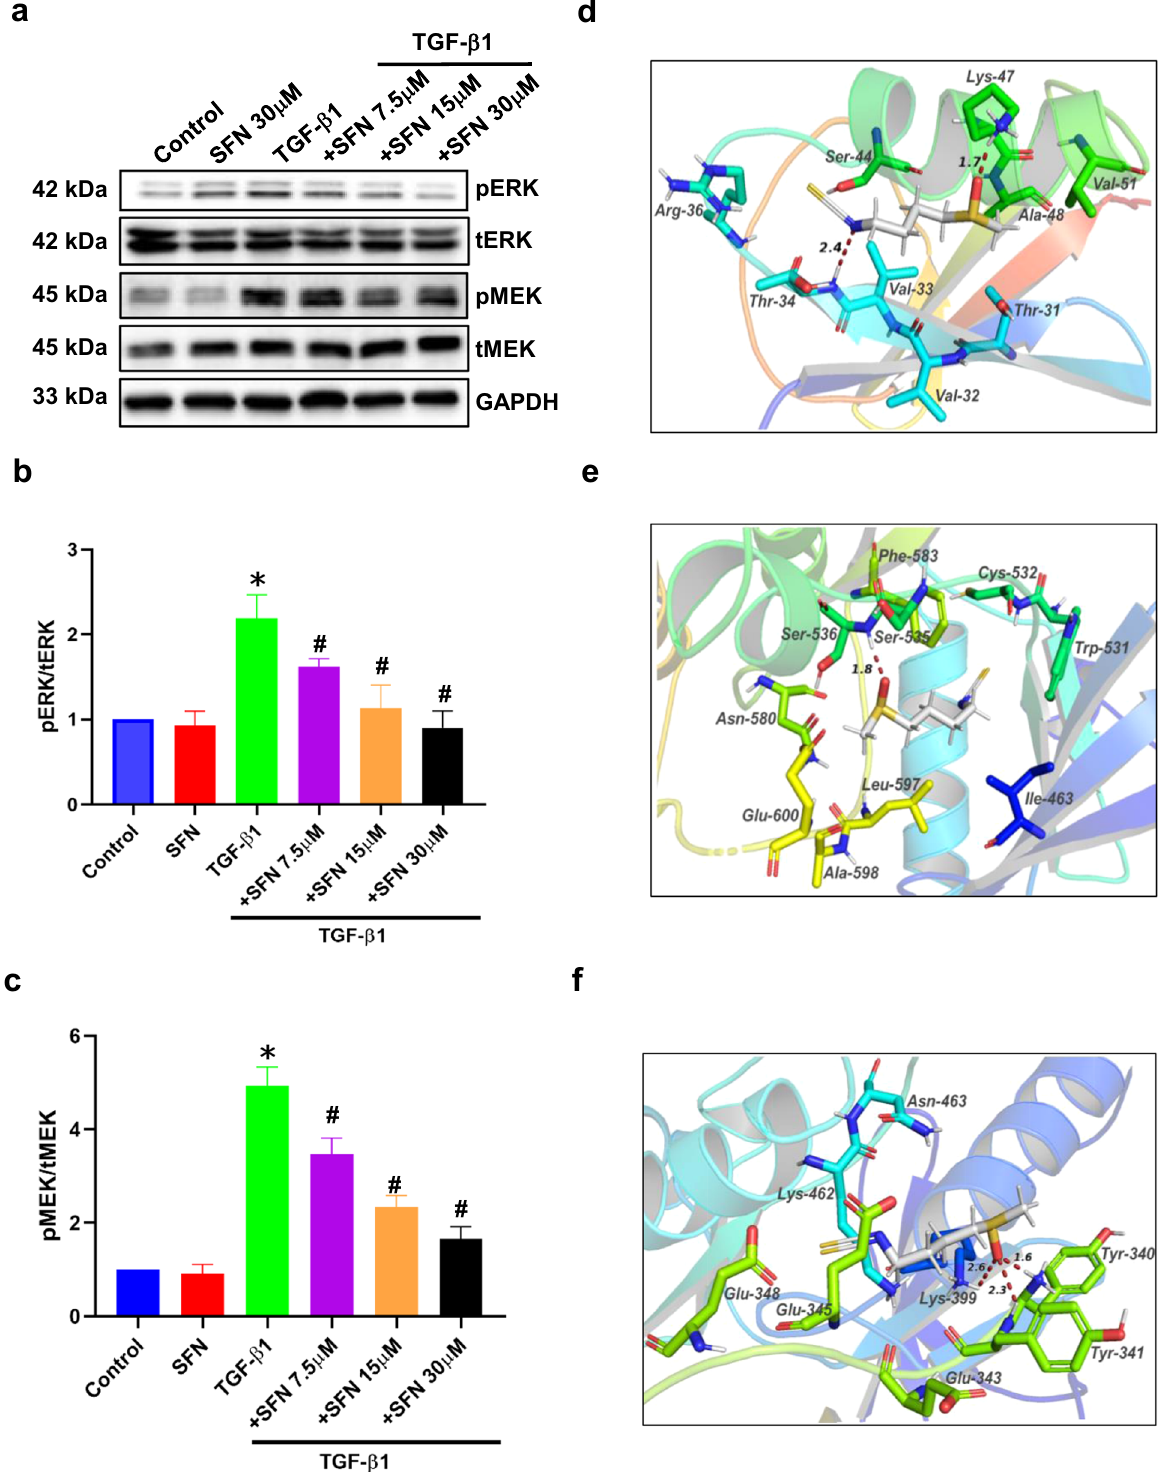
Fig. 8 SFN inhibits TGF- β 1-induced RAF/MEK/ERK pathway by direct binding to RAF family kinases. a Representative western blot results showing the effects of SFN at different concentrations (7.5, 15, and 30 μ M) on TGF- β 1-induced MEK and ERK phosphorylation. b , c Statistical assay showing the effects of SFN at different concentrations (7.5, 15, and 30 μ M) on MEK and ERK phosphorylation, respectively. Data shown are mean ± SEM. n = 3, ∗ P < 0.05 vs Control; # P < 0.05 vs TGF- β 1. d – f Molecular docking showing that SFN directly binds to RAF family kinases, including ARAF, BRAF, and CRAF through H-bond. The dotted lines and the corresponding values present the H-bonds and their distances. pERK phosphorylated ERK, tERK total ERK, pMEK phosphorylated MEK, tMEK total MEK.